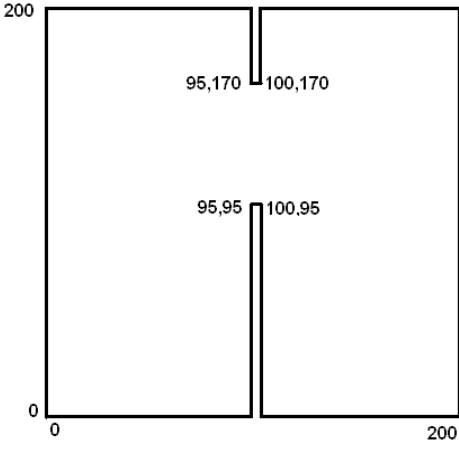
Figure 6. Geometry of the computational domain for partial dam-break.